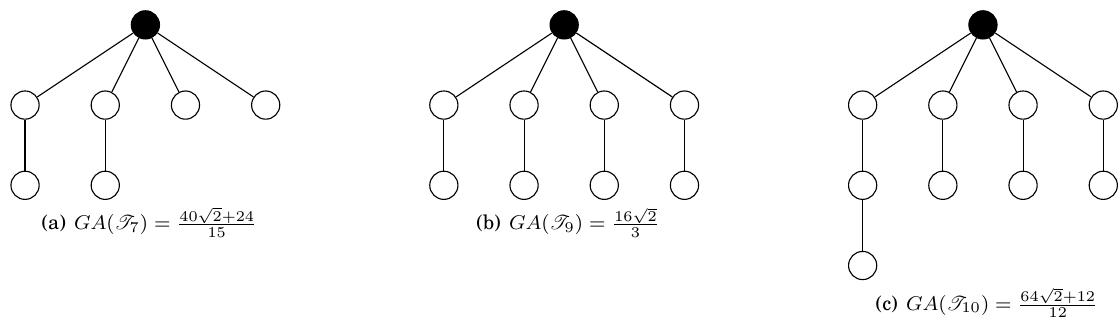
Figure 4: Trees attaining the maximum GA index among trees of maximum degree 4 and orders 7 , 9 , and 10